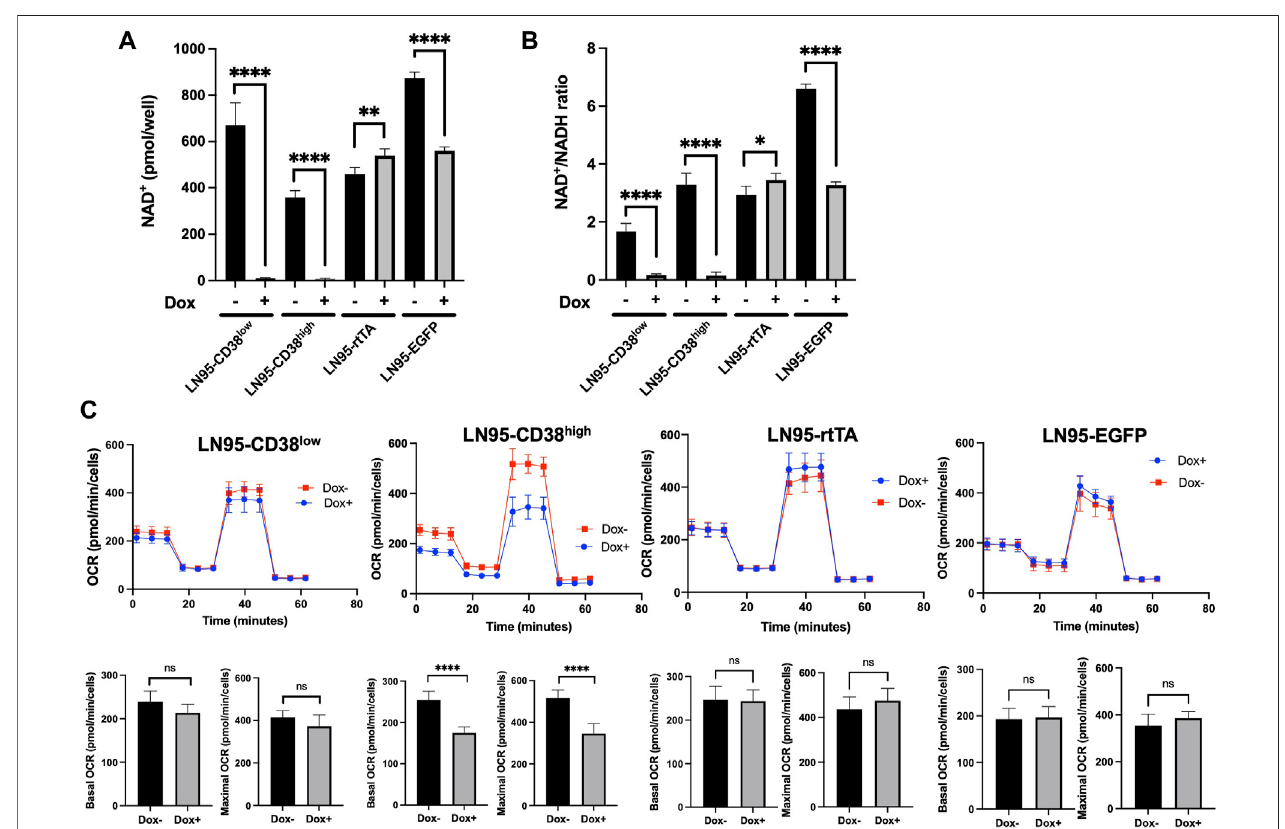
FIGURE3| TheimpactofCD38expressiononintracellularNAD + andmitochondrialrespiration. (A) IntracellularNAD + following100 ng/mlDoxfor48 h*: p < 0.05, **: p < 0.01,****: p < 0.0001. (B) NAD + /NADHratiosfollowing100 ng/mlDoxfor48 h.Mean±SDvaluesfromfourreplicatesareshown.*: p < 0.05,**: p < 0.01,****: p < 0.0001. (C) OCR measured by mitochondrial stress test following 20 ng/ml Dox for 48 h. Basal OCR (measurement point 1) and maximal OCR (measurement point 8) were compared. Mean ± SD values from fi ve replicates are shown. ns: not signi fi cant, ****: p <